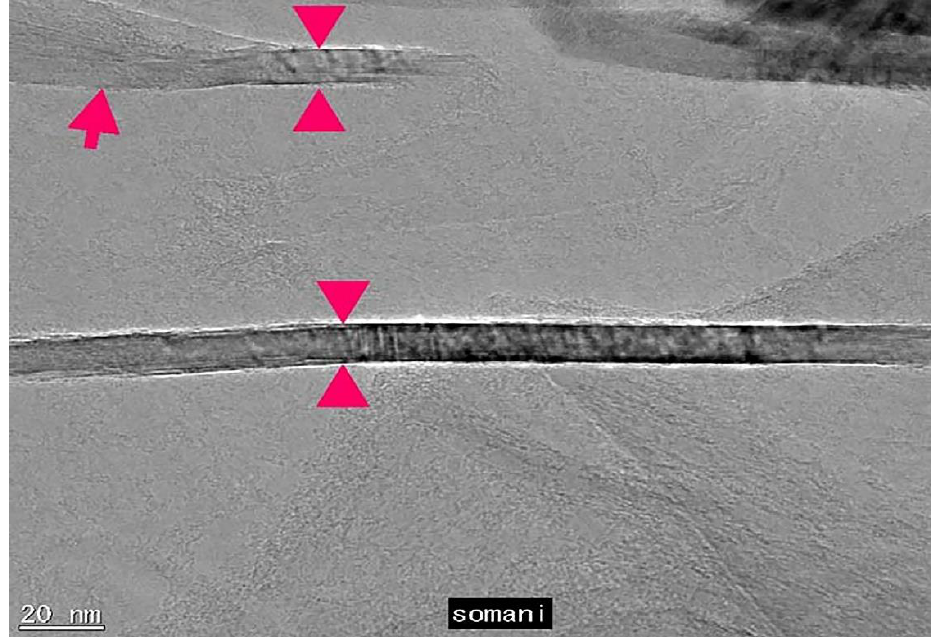
Figure 11. HR-TEM image of PFLG film [120]. Copyright © 2021 Elsevier B.V. and Chemical Figure 11 HR-TEM image of PFLG film [120]. Copyright © 2021 Elsevier B.V. and Chemical Physics Physics Letters.